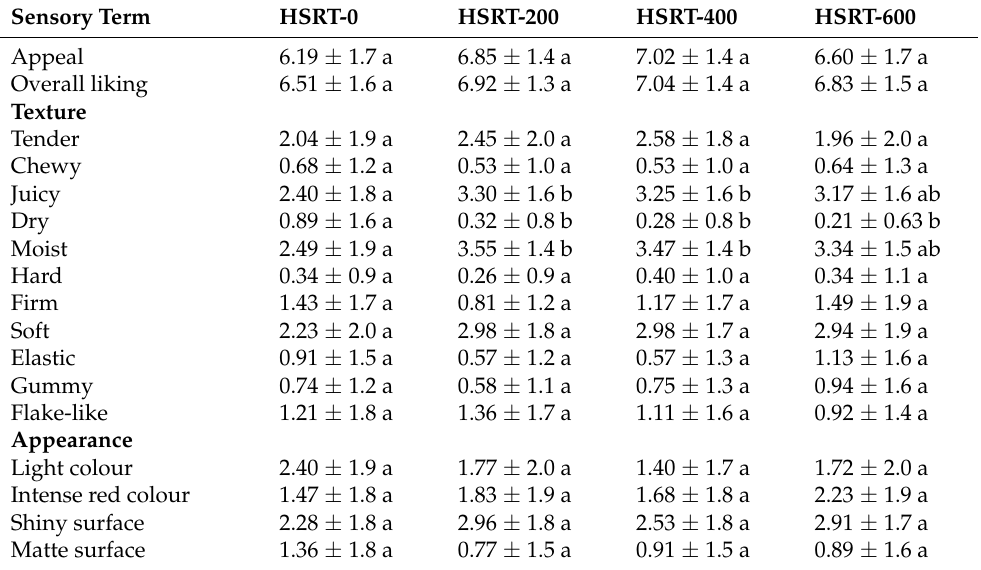
Table 3. The appeal (1 = not appealing at all, 9 = very appealing), overall liking (1 = I do not like it at all, 9 = I like it very much) and Rate-All-That-Apply (1 = slightly applicable, 5 = very applicable) results (average ± standard deviation) of hot smoked rainbow trout (HSRT) samples obtained with consumer sensory evaluation (n =